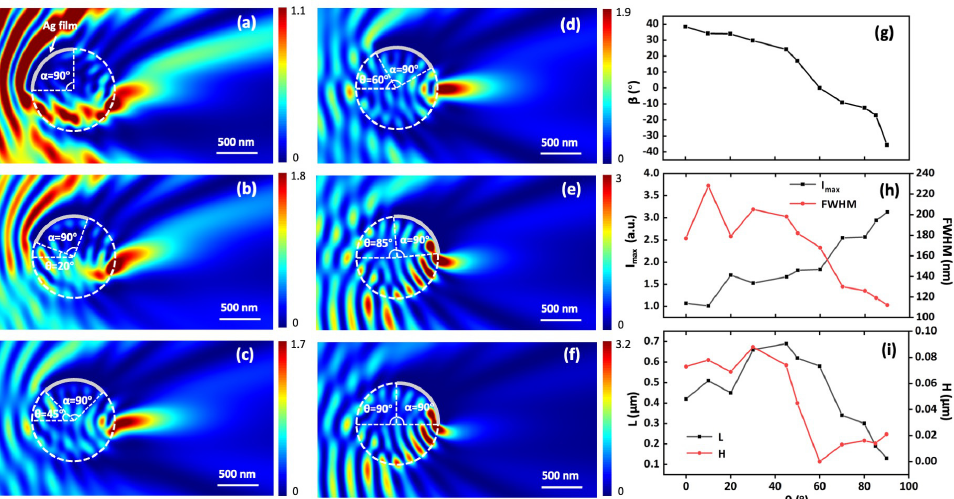
Figure 6. Optical fields of the patchy microcylinders with a diameter of 1 µ m under point-source illumination at the source distance of 5 µ m with α = 90 ◦ at different rotation angles: ( a ) θ = 0 ◦ , ( b ) θ = 20 ◦ , ( c ) θ = 45 ◦ , ( d ) θ = 60 ◦ , ( e ) θ = 85 ◦ , ( f ) θ = 90 ◦ immersed in water. ( g – i ) Characteristics of the light field as a function of rotation angle θ : ( g ) bending angle β , ( h ) maximum intensity enhancement factor I max (black line) and the corresponding FWHM (red line), ( i ) subtense L (black line) and hook height increment H (red